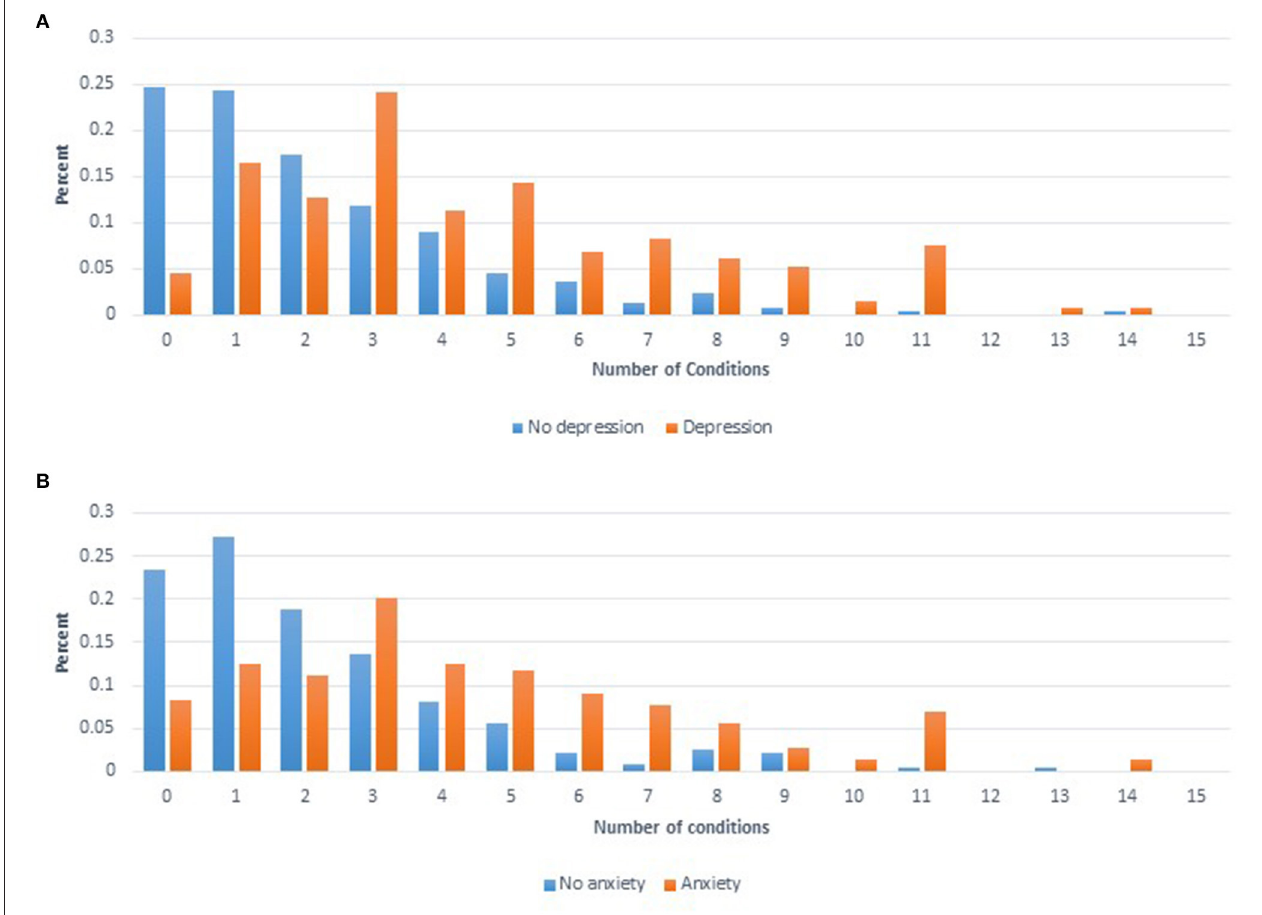
FIGURE 2 | (A) Distribution of number of comorbid conditions reported for women who self-reported having depression (orange) compared to women that self-reported not having depression (blue). (B) Distribution of number of comorbid conditions reported for women who self-reported having anxiety (orange) compared to women that self-reported not having anxiety